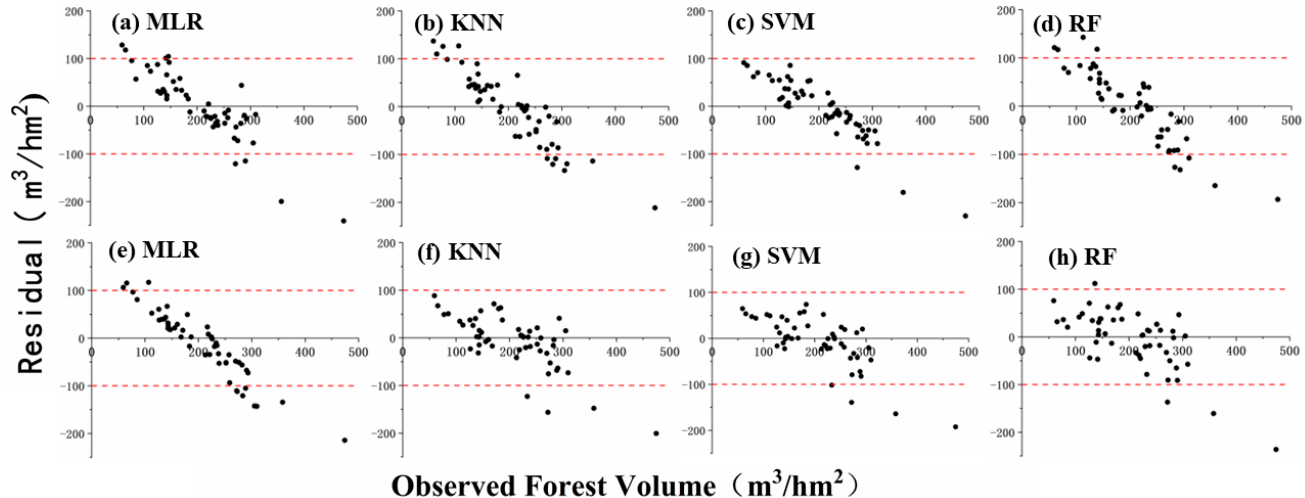
Figure 11. Scatter plots of errors between ground-measured and predicted GSV with different feature selection methods and models; ( a – d ) show results from Sentinel-2 images using Pearson correlation and ( e – h ) show the results from Sentinel-2 images using the proposed method.